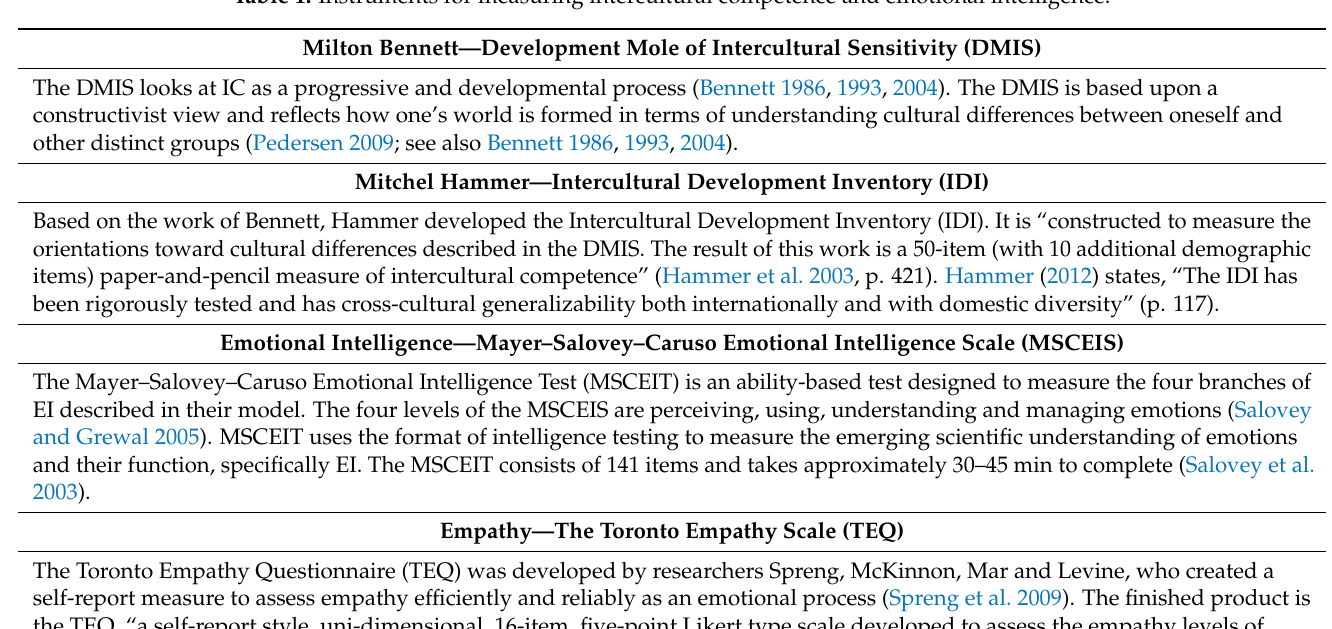
Table 1. Instruments for measuring intercultural competence and emotional